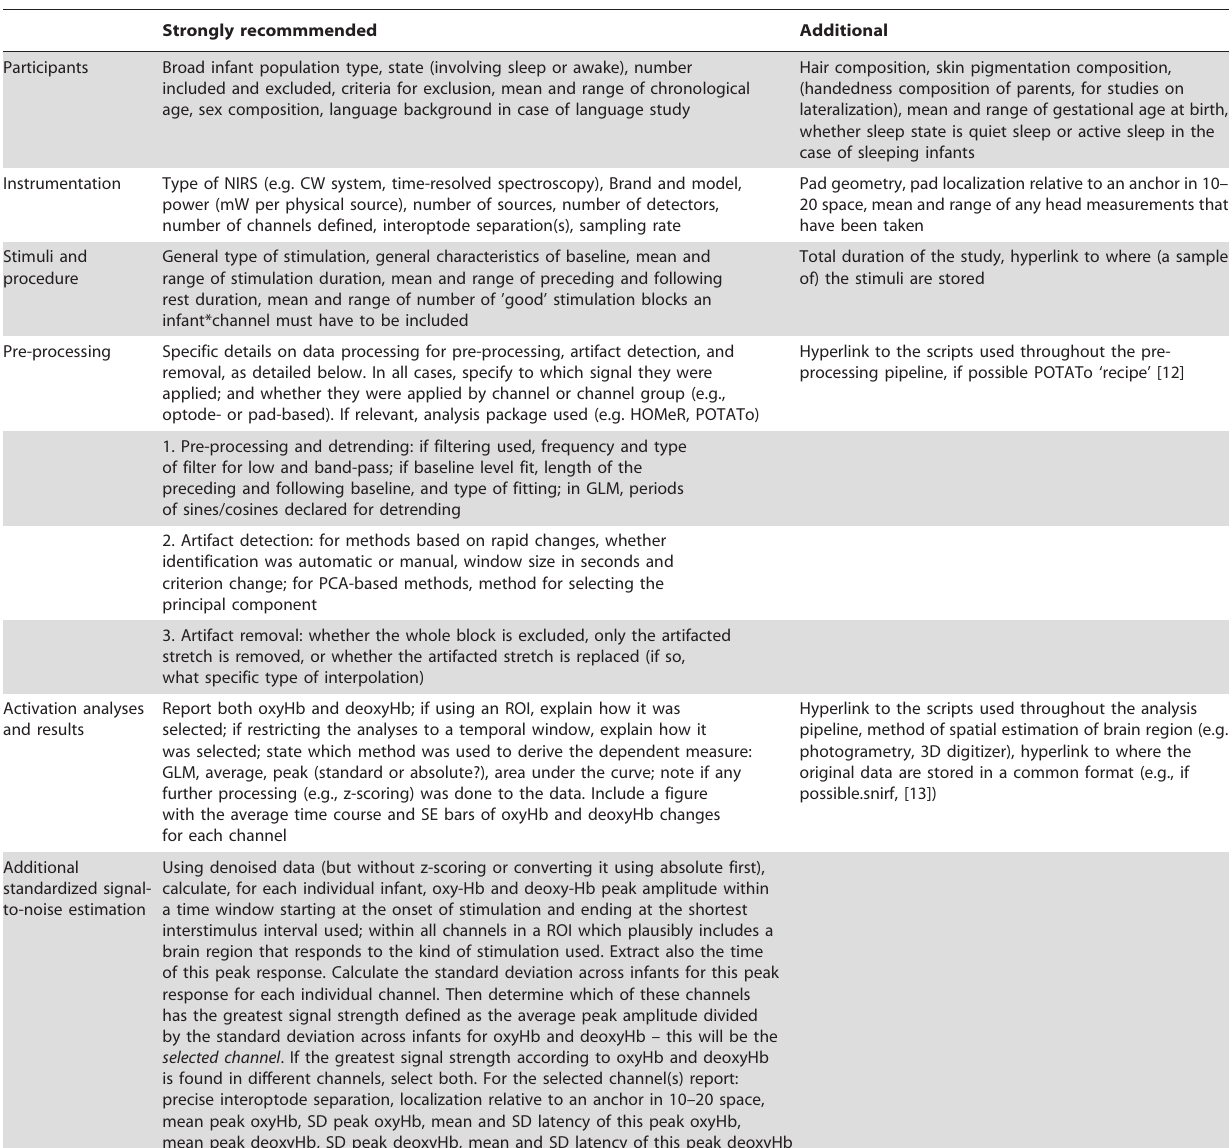
Table 2. Guidelines for infant fNIRS